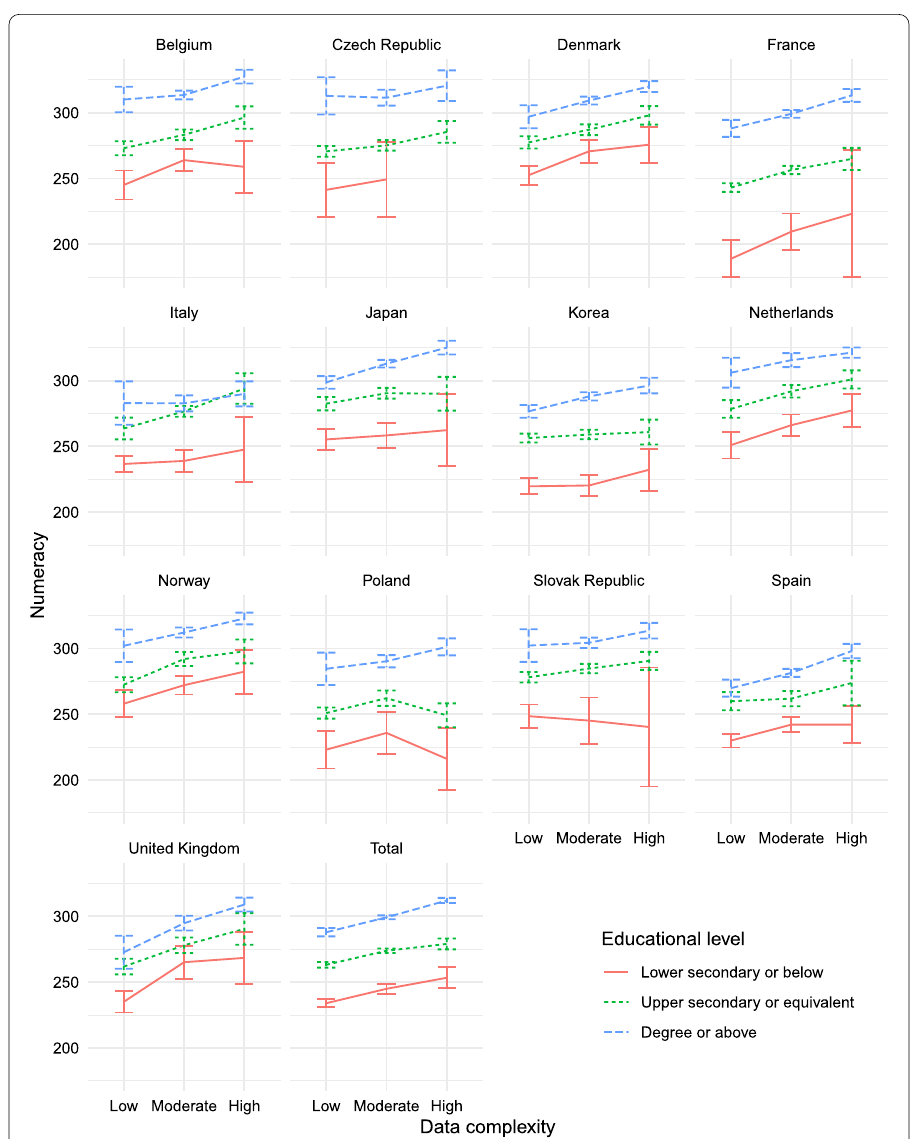
Fig. 2 Relation of complexity with data to numeracy scores among native-born full-time employees in age group 25–65 years in 13 PIAAC countries, for each educational level. Error bars depict 95 % confidence intervals. Source: PIAAC 2012, DOT index, ISCO-08